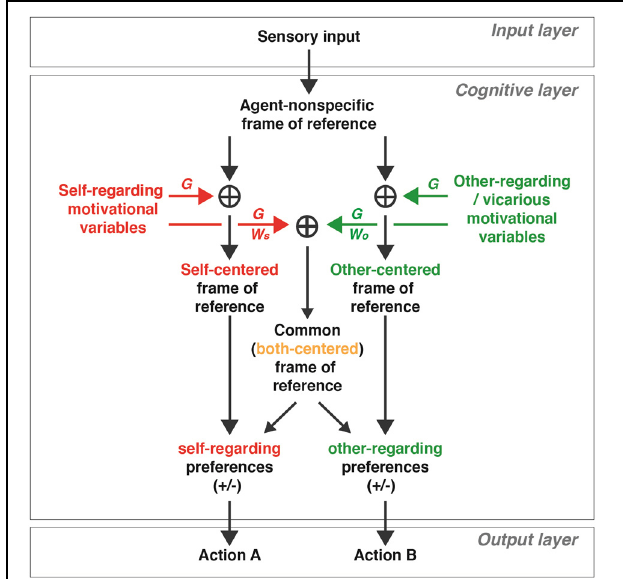
FIGURE 3 | A proposed schematic model of how social variables represented in self- and other-centered, as well as common (both-centered), frames of reference may mediate social interactions. In the cognitive layer, neuronal signals resulting from the environment (input layer) are represented in an agent-nonspecific frame of reference. Motivational (and other cognitive) signals regarding oneself (self motivation variables; see examples in the text) can be added using gain modulations ( G ) to generate a representation in a self-centered frame of reference, whereas motivational (and other cognitive) signals regarding others (other-regarding and vicarious motivation variables; see examples in the text) can be added using gain modulations to generate a representation in an other-centered frame of reference. Neuromodulators (see examples in the text) sets the gain parameters (e.g., magnitude, context) of self- and other-regarding motivational signals in a context-dependent manner. Both self- and other-regarding motivational signals can be added together using gain modulations in a weighted manner ( W S and W O , respectively) to result in a representation in a common (both-centered) frame of reference. The relative distribution of W S and W O determines the strength of self- and other-regarding signals for the both-centered representation. The self-centered signals directly influence self-regarding preferences (either positive or negative in valence, + / − ), whereas the other-centered signals directly influence other-regarding preferences (either positive or negative in valence). On the other hand, the commonly-referenced, both-centered, signals may influence the self- and other-regarding preferences, and the strength of each influence depends on W S and W O . The self- and other-regarding preference signals are relayed to the output layer to generate different social decisions and